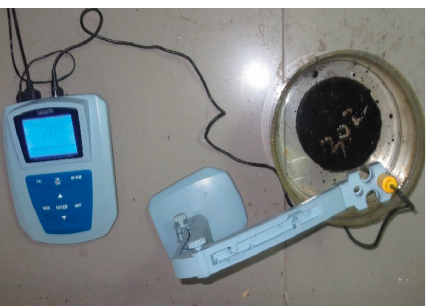
Figure 6: Conductivity meter for salt precipitation